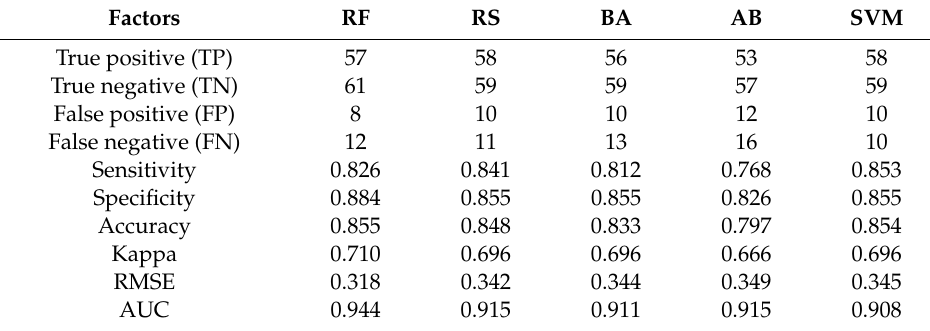
Table 2. Results of the modeling process by training dataset.